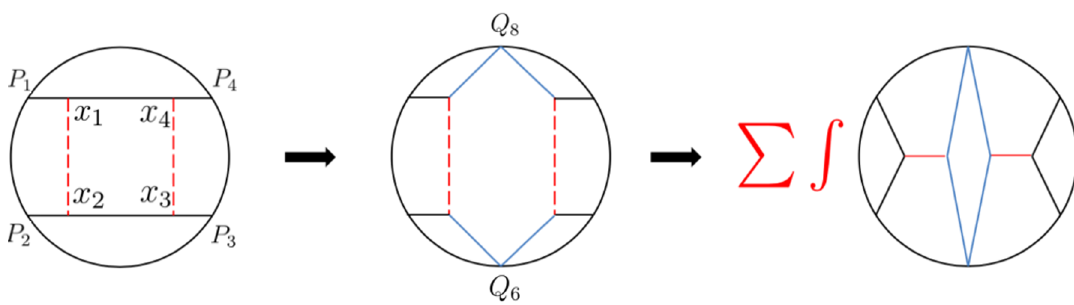
Figure 10 . Schematic explanation of the computation of the one-loop box diagram. First, we rewrite the two horizontal bulk-to-bulk propagators using the split representation. The result is given by a convolution of two tree-level exchange diagrams. Second, we write exchange diagrams in the cross-channel conformal block expansion by using the 6 j